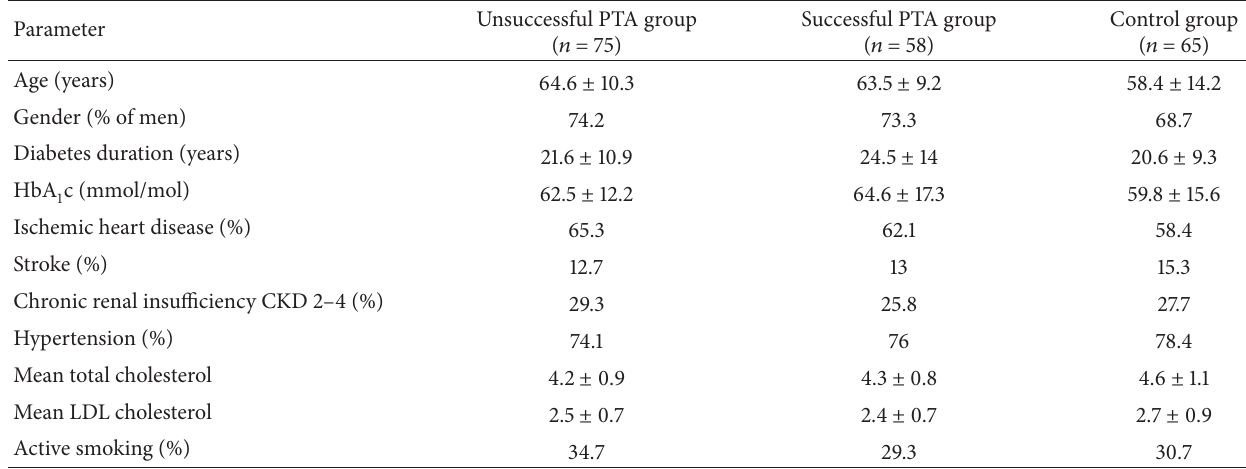
Table 1: Patients’ baseline characteristics ∗ .